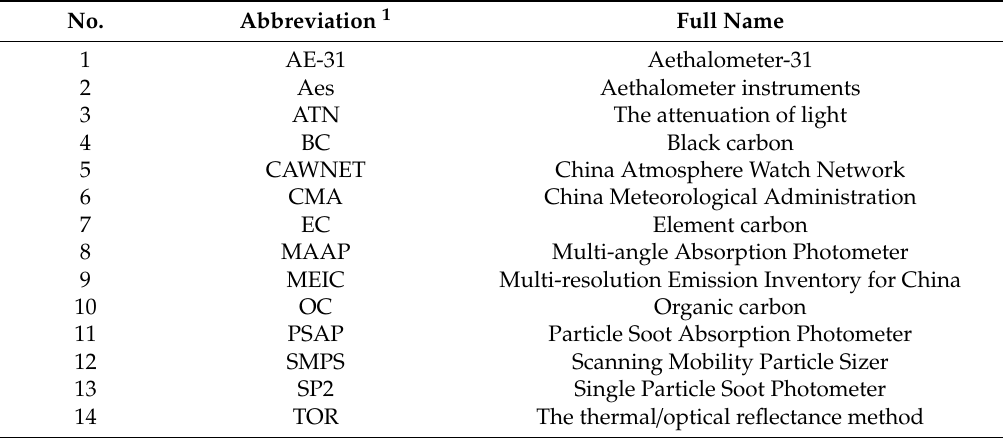
1 abbreviations of city names listed in Table